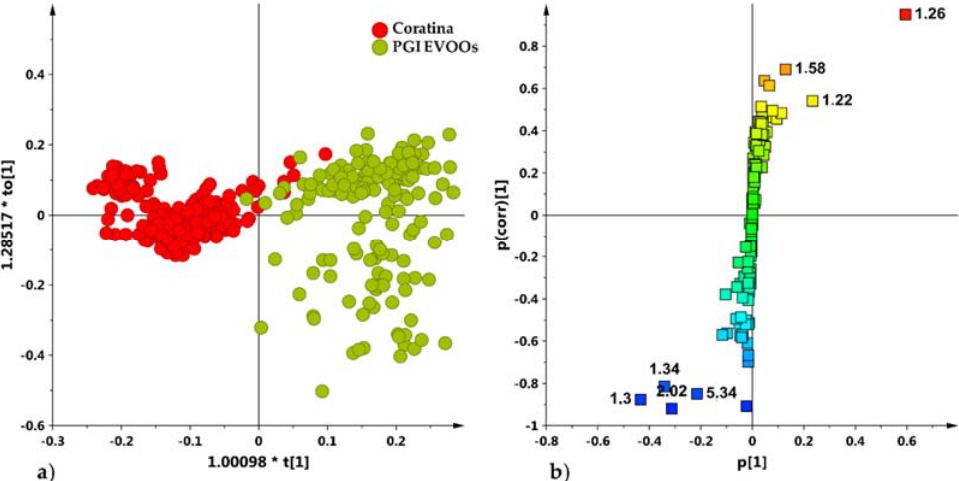
Figure 9. ( a ) OPLS-DA (1 + 1 + 0 components give R 2 X = 0.75, R 2 Y = 0.85, Q 2 = 0.85) scores plot for Coratina cultivar [16] and micro-milled olive oil samples ( b ) S -line plot for the model displaying the predictive loadings coloured according to the correlation scaled loading [p(corr)].